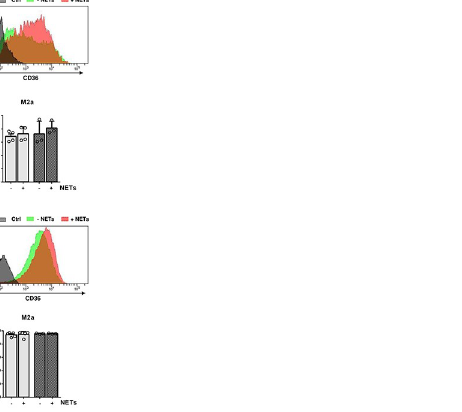
Fig 4. Effect of NETs on CD36 expression on polarized human and murine macrophages. The expression of the oxLDL receptor CD36 on M1- and M2a-like macrophages was quantified by flow cytometry. The median of fluorescence intensity (MFI) as well as the percentage of positive cells were calculated. Representative histograms of 3–5 independent experiments are displayed. � P < 0.05, �� P < 0.01, ��� P < 0.001 (Mann-Whitney test).